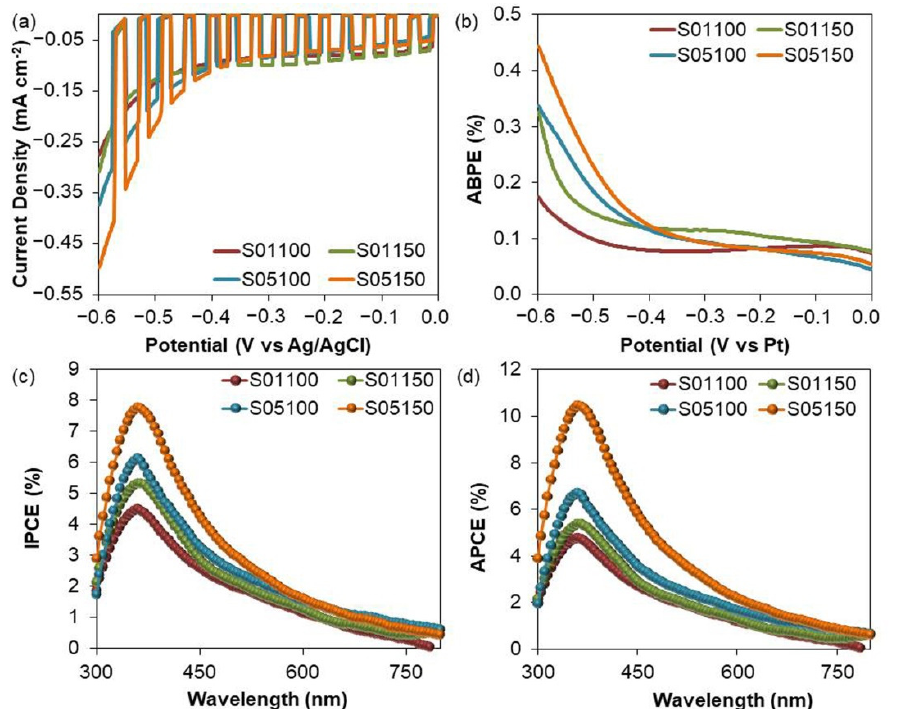
Figure 5. ( a ) The photocurrent density of CuO thin-films at applied potential range from − 0.6 to 0 V (vs. Ag/AgCl); ( b – d ) the ABPE, IPCE, and APCE of CuO thin films, respectively. The photocurrent density reached 0.5 mA/cm 2 at − 0.6 V vs. Ag/AgCl for CuO